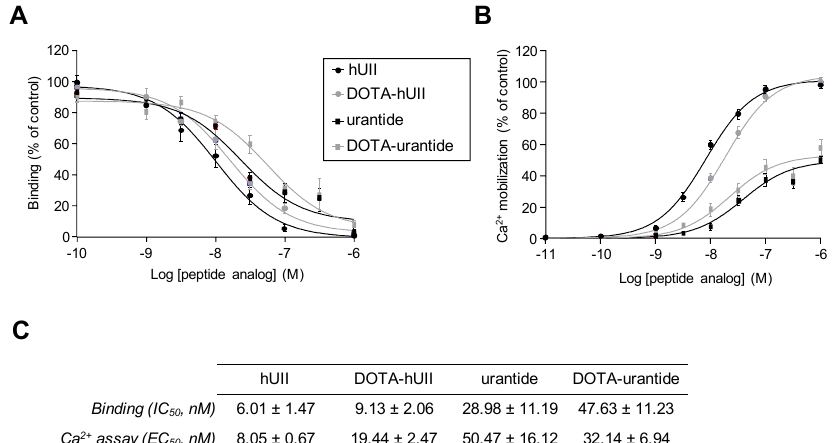
Figure 3. Recognition and activation of UT receptor by hUII, urantide and their DOTA analogues. ( A ) Competitive curves comparing displacement of 125 I-hUII binding by hUII, DOTA-hUII, urantide and DOTA-urantide on HEK-293 cells expressing UT. ( B ) Calcium mobilization provoked by graded concentrations (10 − 11 to 10 − 6 M) of hUII, DOTA-hUII, urantide and DOTA-urantide on HEK-293 cells expressing UT. ( C ) Table summarising IC50 (binding) and EC50 (calcium assay) values (nM). Data are mean of at least four independent experiments performed in triplicate.